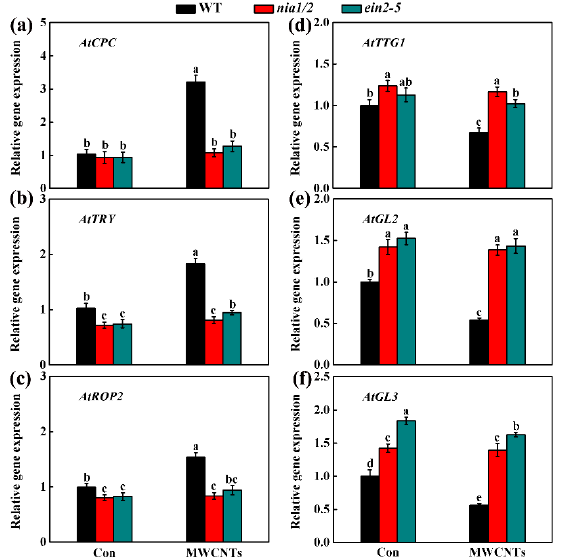
Figure 8. Changes in the transcripts of genes related to root hair formation in Arabidopsis . Five-day- old WT, nia1/2, and ein2-5 mutants were grown on MS medium for 5 d, and then transplanted to medium with or without 10 mg/L MWCNTs for 24 h. Seedlings grown on MS medium without MWCNTs were the control (Con). Afterwards, the mRNA expression of AtCPC ( a ), AtTRY ( b ), AtROP2 ( c ), AtTTG1 ( d ), AtGL2 ( e ), and AtGL3 ( f ) in root tissues were analyzed by qPCR. Bars with different letters are significantly different at p < 0.05, according to Duncan’s multiple range test.